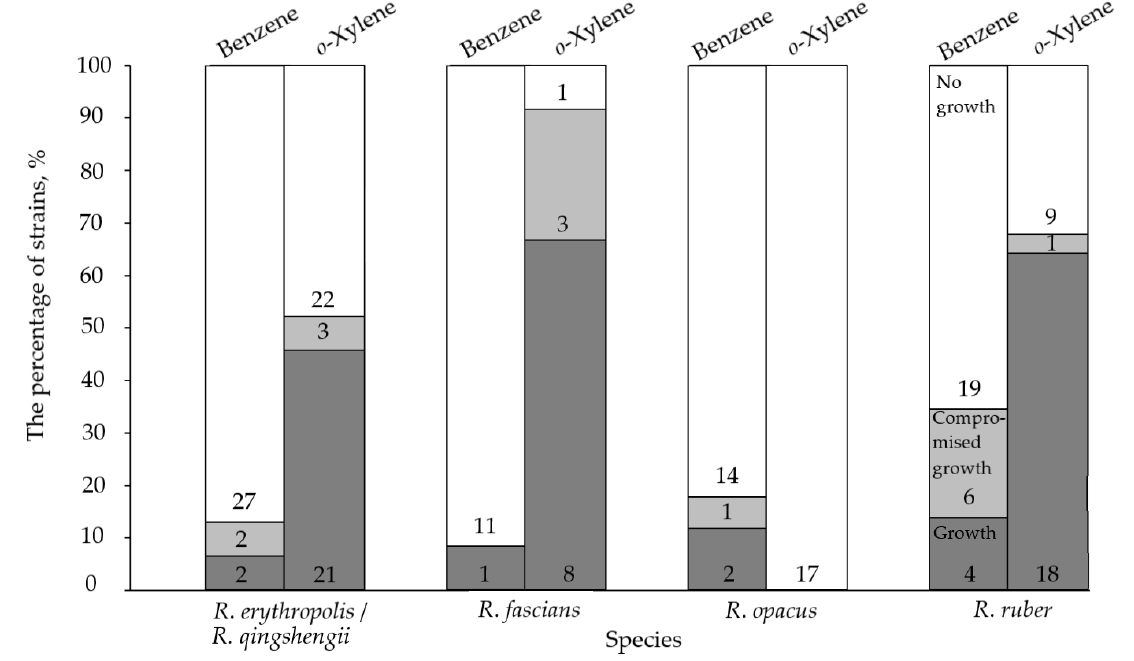
Figure 1. Growth of strains of the most represented Rhodococcus species in the presence of benzene and o- xylene. The numbers in the columns show the number of strains able to use benzene or o- xylene as growth substrates (shaded columns) or unable to grow in their presence (white columns). Compromised growth means weak growth (the growth that was not detected in all replicates).